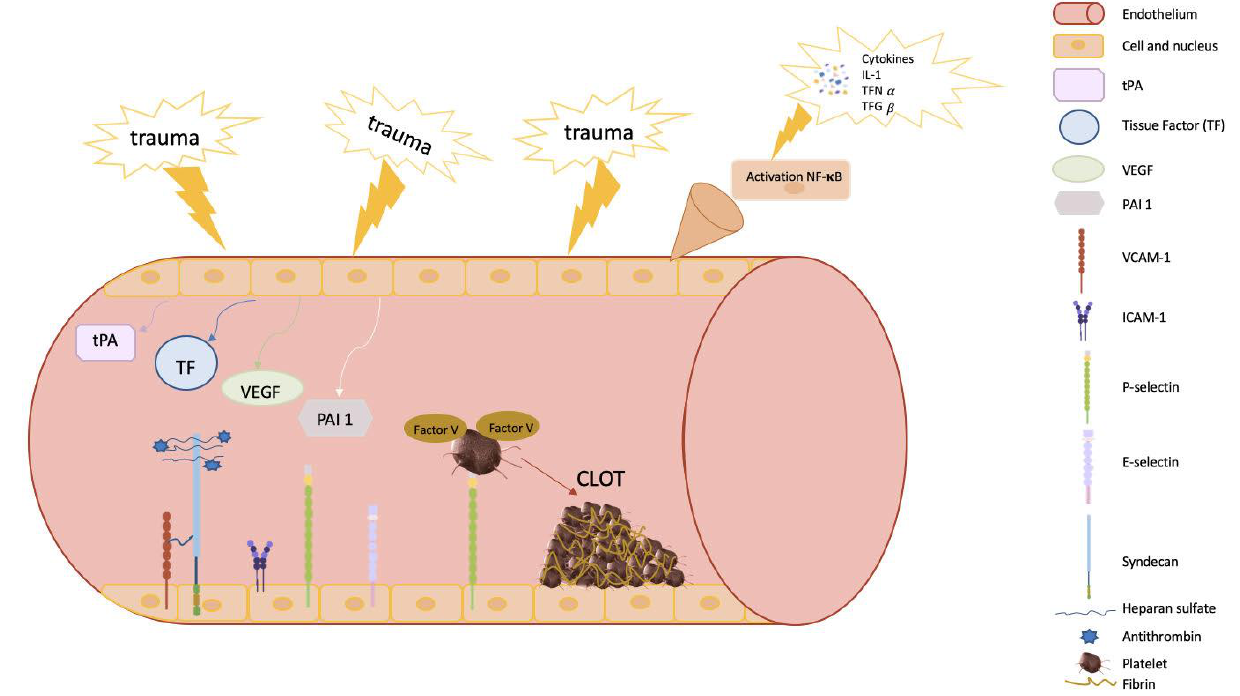
Figure 2. Diagram of the main components of endothelial vessels involved in clot formation. The endothelium plays a key role in coagulation. First, following trauma and injury to the endothelium, it contributes to platelet aggregation and recruitment of cells that participate in the conversion of fibrinogen to fibrin, forming a network and ultimately creating the clot. In addition, the endothelium is closely related to the PI3K/AKT pathway and endothelial factors (VCAM and ICAM). VCAM-1 contributes to the activation of PI3K. Moreover, the endothelium can activate antithrombin III, which is bound to syndecan by binding antithrombin to the endothelial surface and increasing the inhibitory action on the coagulation cascade. Inflammation is initiated by the release of TFN- α , triggering a series of molecules—selectins, VCAM, and ICAM—to recruit lymphocytes. VEGF can increase VCAM expression in endothelial cells. Vascular endothelial homeostasis is an important contributor to the process of fibrinolysis. VEGF, vascular endothelial growth factor, activates the expression of tissue plasminogen activator (tPA) and plasminogen activator inhibitor-1 (PAI-1). In addition, adhesion molecules (VCAM-1 and ICAM-1) expressed by the endothelial cells and released into the blood contribute to platelet adhesion, activation, and aggregation, and may activate procoagulant factors which, in turn, also contribute to platelet adhesion and